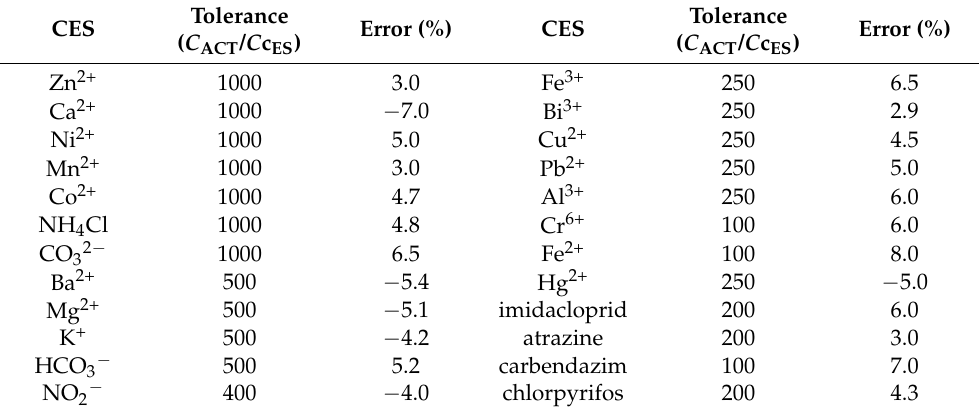
Table 2. Effect of coexisting ions (CES).